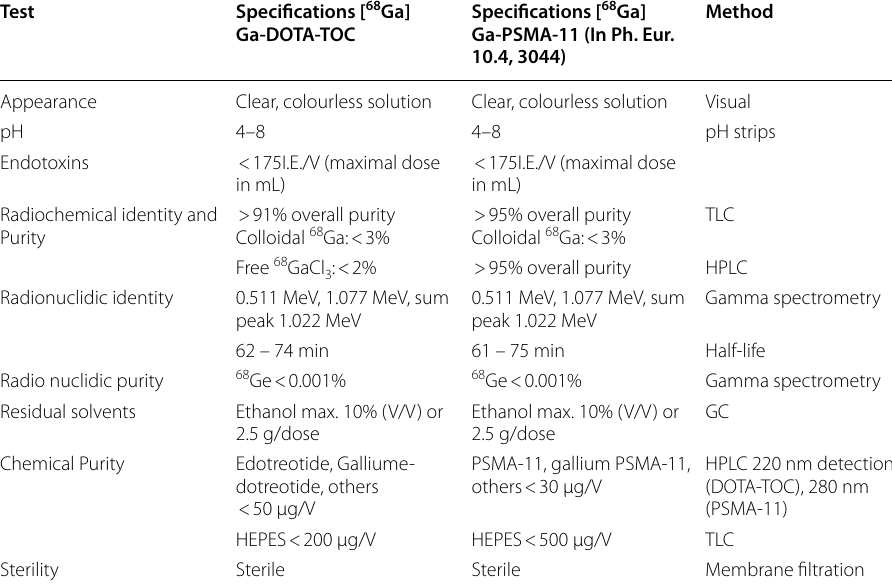
Table 4 Specifications of [ 68 Ga]Ga-DOTA-TOC and [ 68